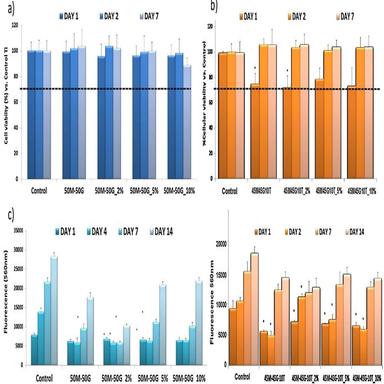
Cell viability for: a) 50M50G and b) 45M45G10T materials expressed as a percentage of viability in control samples. And adhesion and proliferation of HFBs on c) 50M50G and d) 45M45G10T coatings on titanium after 1, 3, 7 and 14 days of culture (——=70% cell viability threshold;\ = p < 0.05 with respect to Control; + = p < 0.05 with respect to 50M50G).